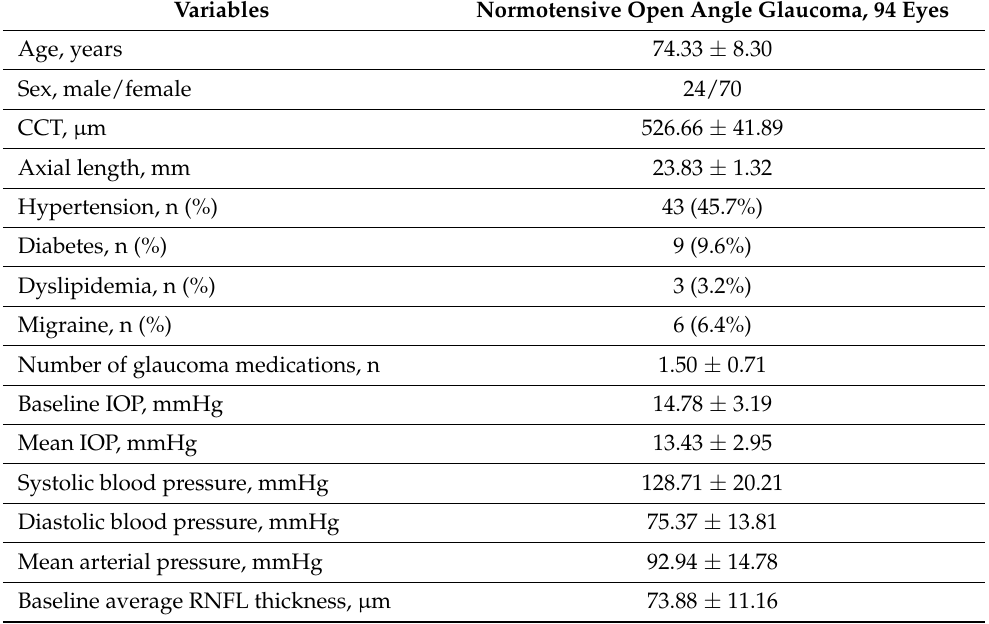
Table 1. Baseline demographcs of patients with normotensive